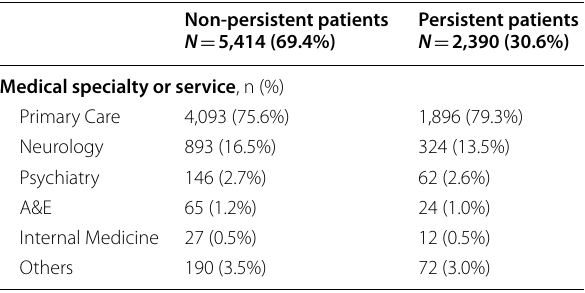
Table 2 Prescription of first migraine preventives by healthcare